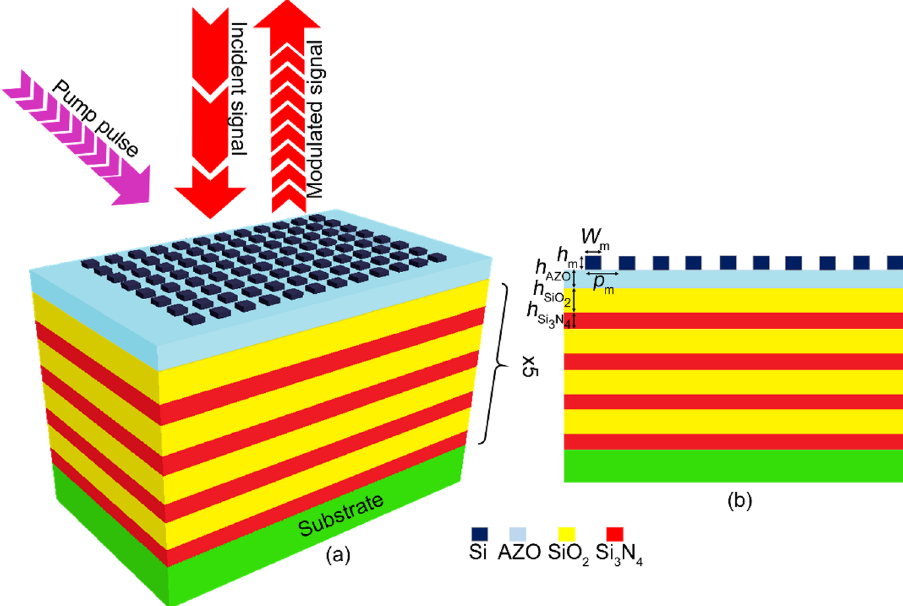
Figure 1. Schematic ( a ) perspective and ( b ) side view of the proposed modulator .